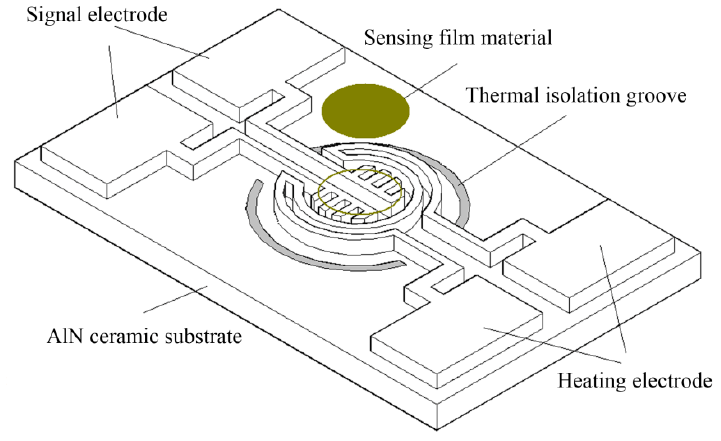
Figure 1. Structural schematic of the ceramic micro hotplate sensor.